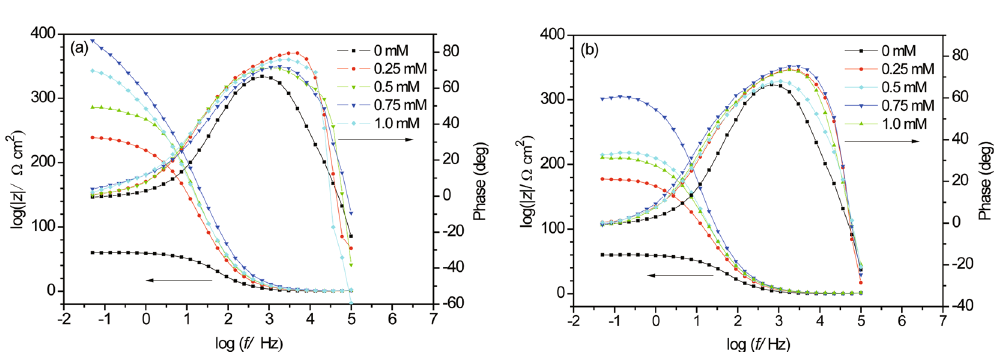
Figure 3. Nyquist plots for carbon steel in 0.5 M HCl solution without/with different concentrations of BAIL1 ( a ) and BAIL2 ( b ).